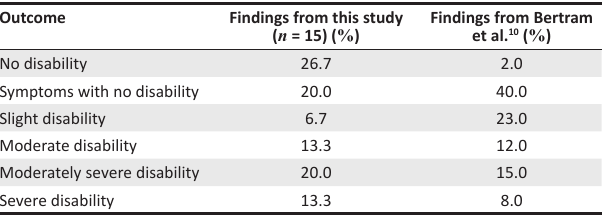
Findings from Bertram ( n = 15) ( % ) et al. 10 ( % )